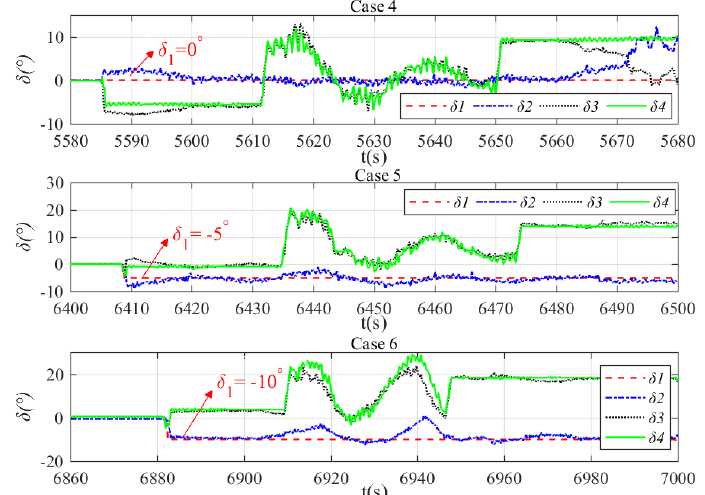
Figure 23 . Results of NLP-based command transformation with rudder jam. Rudder commands in case 4 (top), rudder commands in case 5 (middle), and rudder commands in case 6 (bottom).